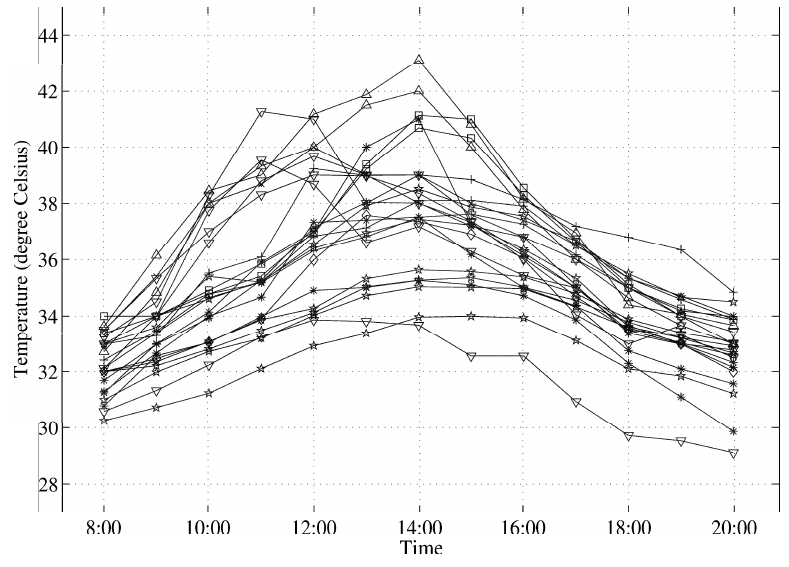
Figure 5. Temperature change measured by 23 sensors placed in a 250m-by-340m area on August 22,